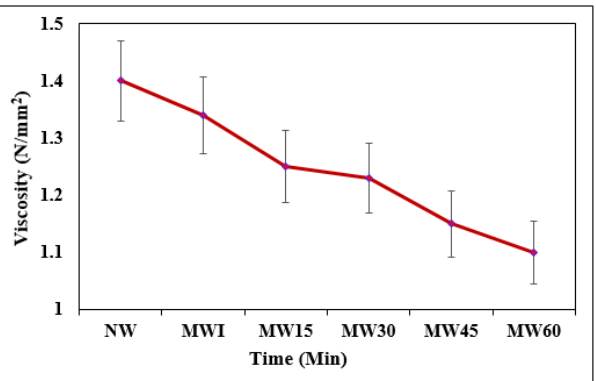
Figure 5. Variation in viscosity of NW and MW with exposure time.